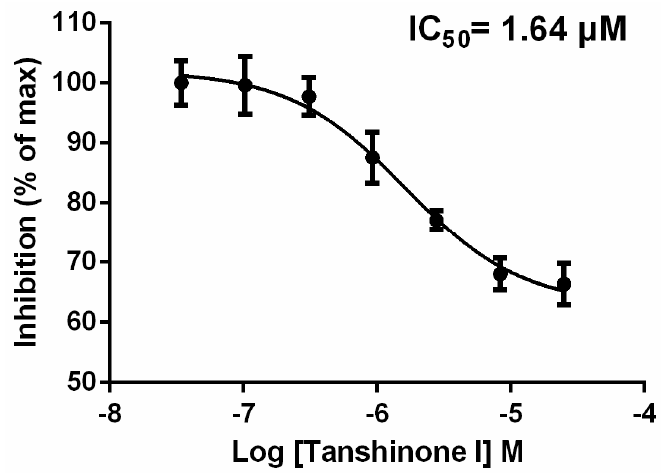
Figure 4. The dose-response curve of tanshinone I inhibition of Syk activity. All error bars represent the SE of three replicates.